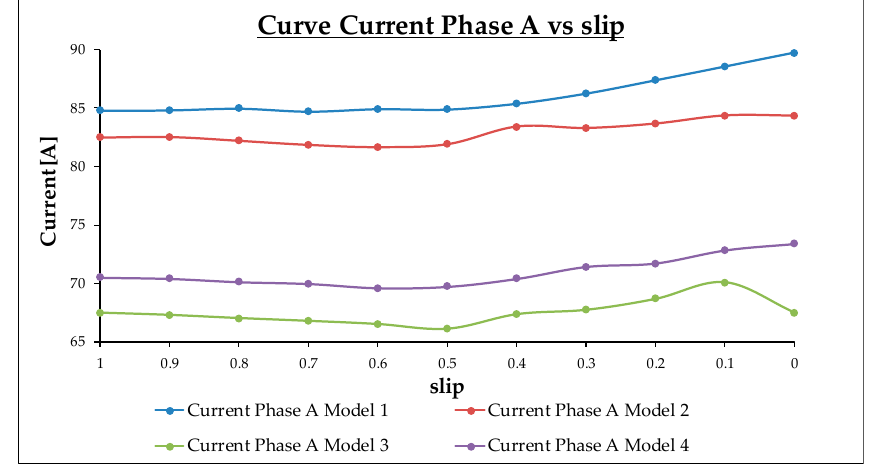
Figure 32. Electric current phase A versus slips.